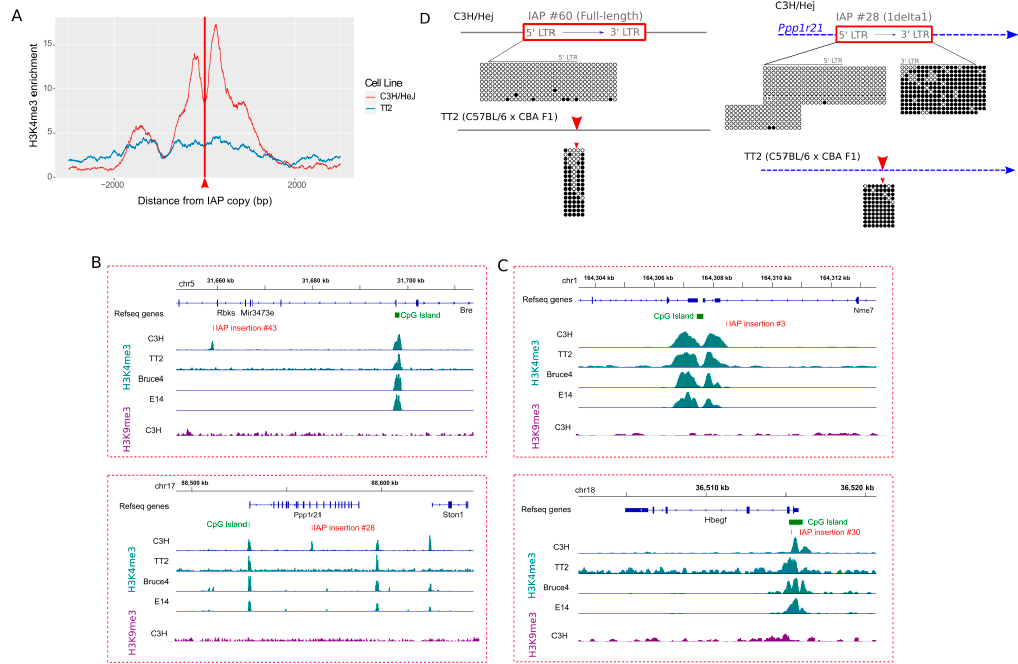
Figure 4. IAP copies are able to recruit H3K4me3 chromatin. ( A ) Average enrichment of H3K4me3 in TT2 (C57BL / 6 × CBA) and C3H / HeJ ES cells in 27 regions flanking IAP copies present in C3H / HeJ and absent from C57BL / 6 and CBA. The red arrow and line represents the IAP insertion site. ( B , C ) IGV genome browser view of IAP copies inserted in C3H / HeJ and absent from other mouse strains. IAP copies #43 and #28 are able to recruit H3K4me3 ( B ), while the empty sites in TT2, Bruce4 and E14 show no H3K4me3 enrichment. For comparison, the closest H3K4me3-marked promoter is shown. IAP copies #3 and #30, present only in C3H / HeJ, are inserted within H3K4me3-marked regions ( C ), as seen in the empty sites of TT2, Bruce4 and E14. ( D ) Bisulfite analysis of two empty sites in TT2 cells corresponding in C3H / HeJ to the full-length insertion (IAP copy #60) and a 1 ∆ 1 insertion in the Ppp1r21 gene (IAP copy #28). The methylation profile in C3H / HeJ cells, presented in Figure 3E, is shown here for comparison. Empty circles are unmethylated CpGs, full circles are methylated ones. The arrow inside the IAP insertion box depicts the IAP direction and the line above the CpG circles represents the CpGs within the LTRs. Red boxes are IAP insertions; in blue, genes; in black, intergenic regions. The red arrow head represents the C3H / HeJ IAP insertion site in the empty C57BL / 6